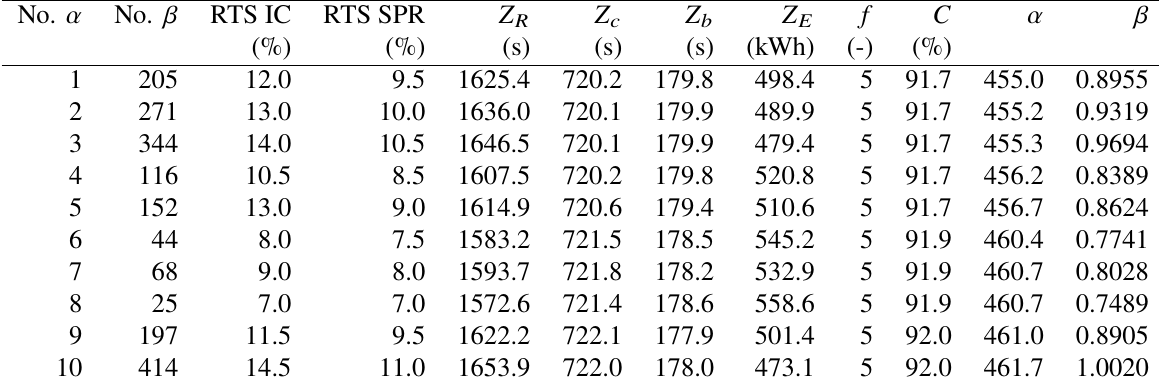
Table 4: First 10 Pareto-optimal solutions with 0 s minimum buffer time considering the objec- tives total running time 𝑍 , extended cycle time 𝑍 , buffer time 𝑍 and energy consumption 𝑍 𝑅 𝑐 𝑏 for the real-world case Ah-Nm using the weighted sum method (sorted from low to high accord- ing to 𝛼 ).